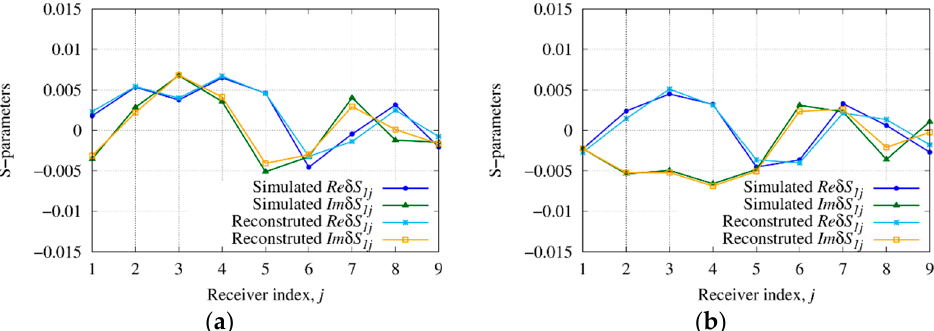
Figure 10. Simulated and reconstructed scattering S -parameters (real and imaginary part) when the first antenna acts as the source. Target centered at ( a ) y t = − 20 cm and ( b ) y t = − 25 cm.